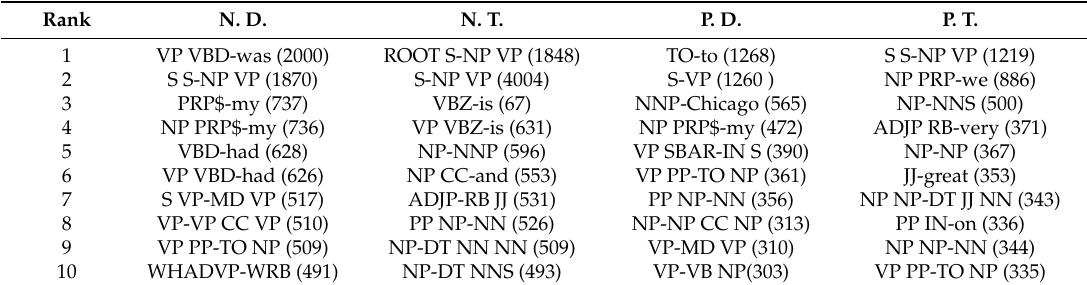
Table 3. The top 10 distinct PCFG rules adopted in deceptive and non-deceptive hotel reviews. N.D.: rule occurring in negative deceptive reviews; N.T.: rule occurring in negative true reviews; P.D.: rule occurring in positive deceptive reviews; P.T.: rule occurring in positive true